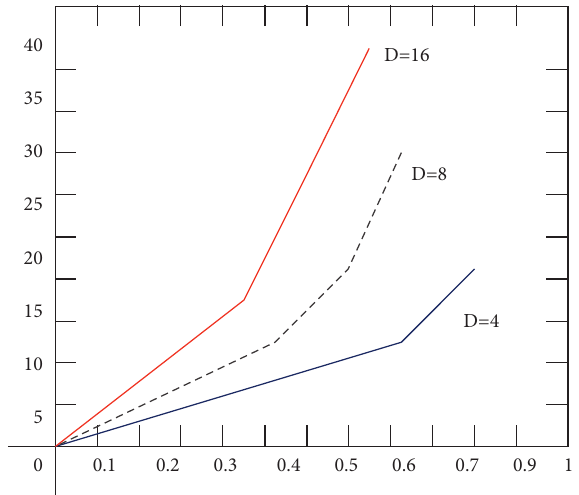
Figure 3: Expansion factor-GT value